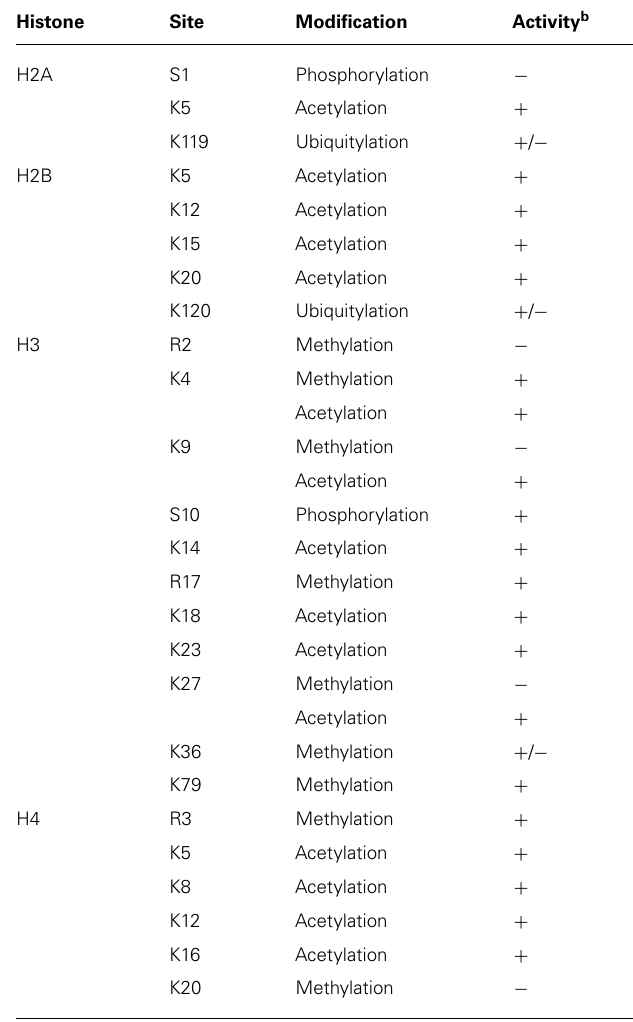
Table 1 | Histone modifications and their association with gene expression a